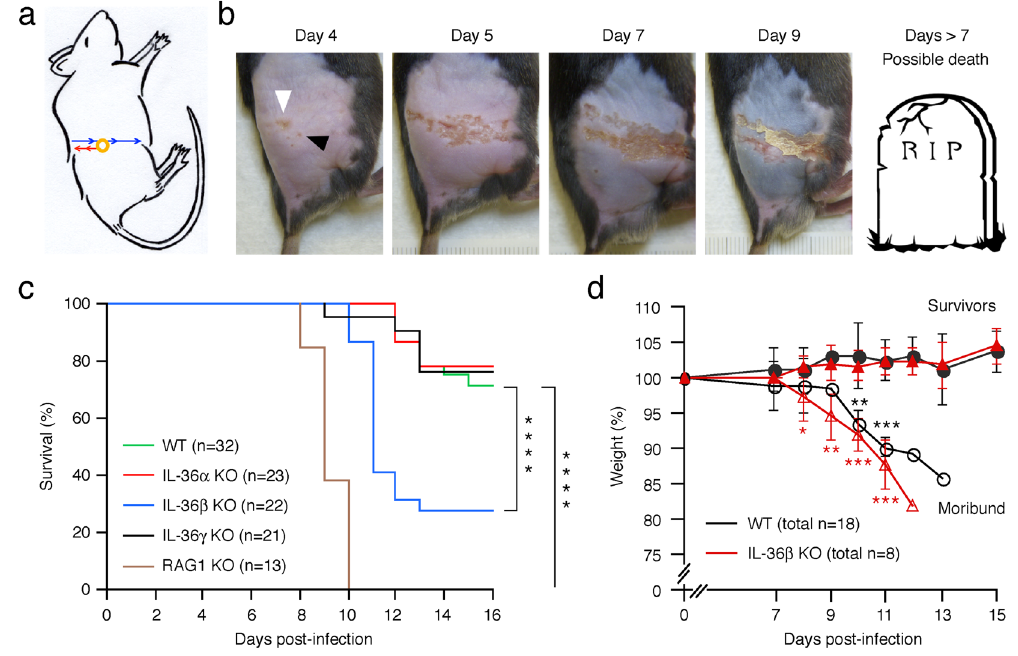
Figure 2. IL-36 β , but not IL-36 α or IL-36 γ , provides protection against lethal outcome of HSV-1 infection. ( a ) Illustration of inoculation site (yellow circle) and directions of retrograde (red arrows) and anterograde (blue arrows) migration of HSV-1 through neurons. ( b ) Progression of disease in wild type mice (C57BL/6) infected with 1.5 × 10 6 PFU HSV-1 on flank skin (white arrowhead) at day 0 is depicted at the indicated time-points. Black arrowhead points to early secondary lesion appearing along sensory neurons (note the linear progression of the lesions). Ruler used for quantification of lesion sizes visible in day 9 image. Image of gravestone can be found at: https://freeclipartnow.com/holidays/halloween/graveyard/R-I-P-gravestone.jpg.html. ( c ) Wild type (C57BL/6, green), IL-36 α − / − (red), IL-36 β − / − (blue), IL-36 γ − / − (black), and RAG1 − / − (brown) mice were infected with 1.5 × 10 6 PFU HSV-1 on the right flank on day 0, and survival monitored for 16 days. n indicates number of mice per group. Data shown is pooled from 6 independent experiments. Statistical significance was determined using Mantel-Cox and Gehan-Breslow-Wilcoxon tests; **** p < 0.0001. ( d ) Wild type (C57BL/6, n = 18, black lines and symbols) and IL-36 β − / − (n = 8, red lines and symbols) mice were infected with HSV-1 as described above. Pooled weight data (means ± SD) of survivors (closed symbols) and mice progressing to become moribund (open symbols) from two independent experiments is shown. * p < 0.05 (comparing survivors to moribund within each strain); ** p < 0.01; *** p <